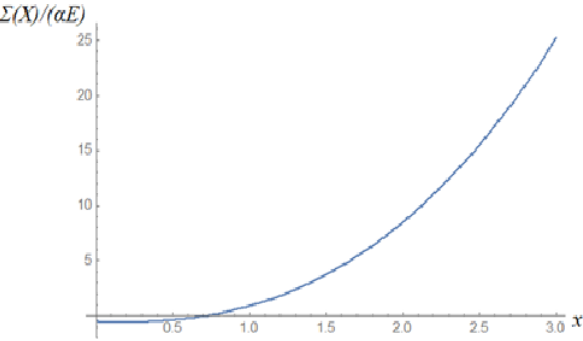
Figure 9: The distribution of stresses in the fractional with horizon Λ -space with respect to the initial x axis